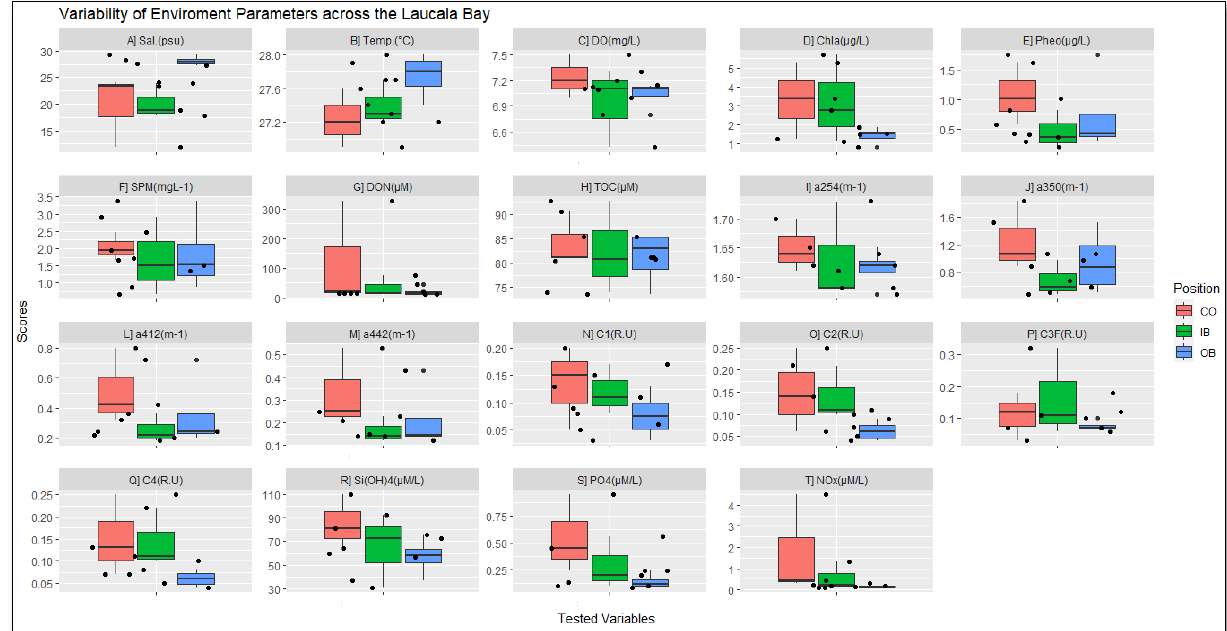
Figure 6. Boxplots showing the distribution of environment parameters along with the CO (red), IB (green), and OB (blue). It visualizes five summary statistics: the median (horizontal line in the middle of Table 3.